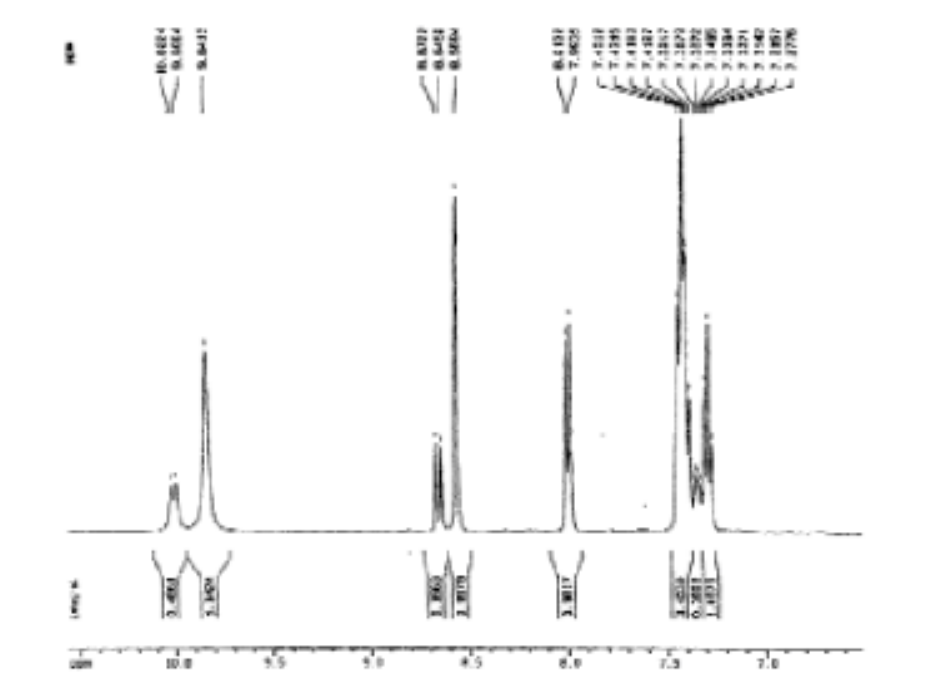
Figure 1. Aromatic part of the 1 H-NMR spectrum of 2 (in DMSO- d